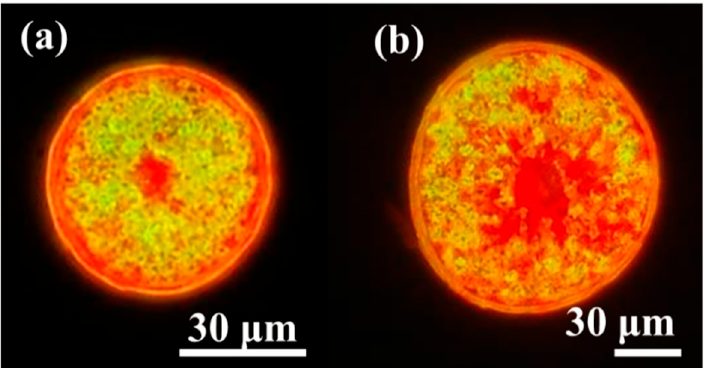
Figure 5. Distribution of two types of cortical cells: ( a ) flexible/elastic hair (Table 1; No. 1) [18], ( b ) inflexible/inelastic hair (Table 1; No. 10). The para-like cortical cells look green and the ortho-like cortical cells look red in these pictures.